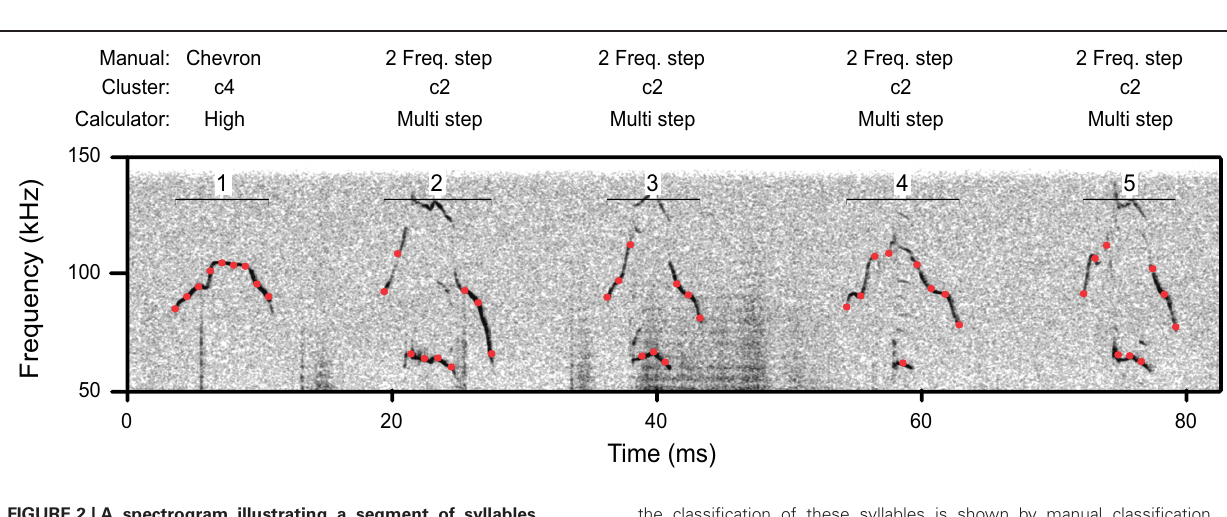
representing 95% confidence intervals for the individual pups contributing to the litter.There werenosignificant inter-litter effects. (A) Theaverage dominant frequency, (B) average syllable duration, (C) average syllable bandwidth.